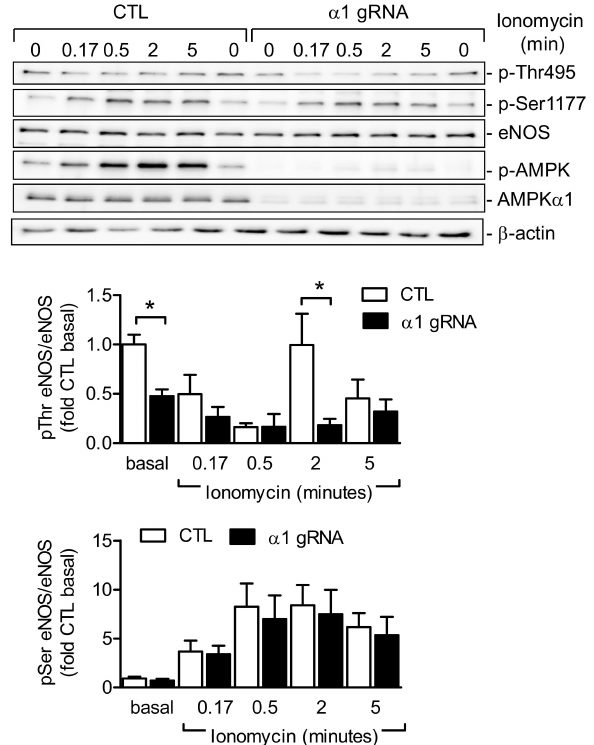
Figure 6. Effect of AMPK α 1 deletion on the ionomycin-induced phosphorylation of eNOS on Thr495 and Ser1177. The AMPK α 1 subunit was deleted in cultured human cells using the “clustered regularly interspaced short palindromic repeats” (CRISPR)/CRISPR-associated protein 9 (Cas9) system and AMPK α 1-specific guide RNAs (gRNAs), and was stimulated with ionomycin (100 nmol/L) for up to 5 min. Representative Western blots are shown of six independent experiments. Bar graphs summarize the evaluation of p-eNOS to total eNOS ( n = 6); * p < 0.05 versus control guide